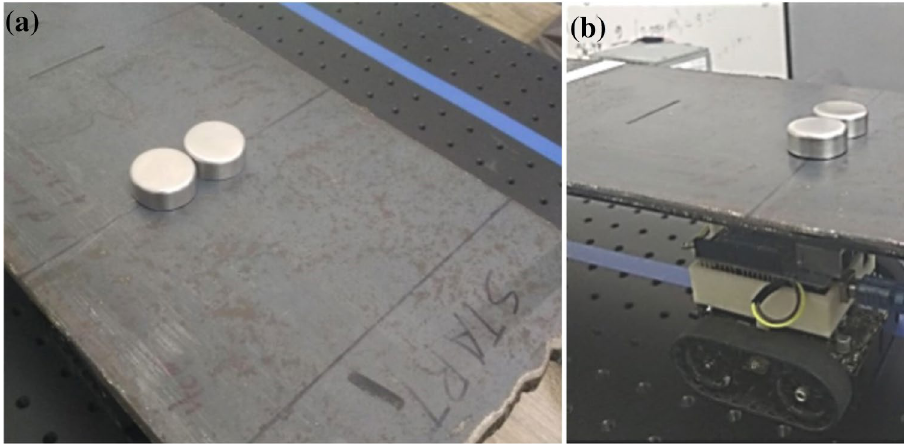
Fig. 6 Magnetization of the plate to orient the magnetics domain a top view, b side view of the setup using a perma- nent neodymium